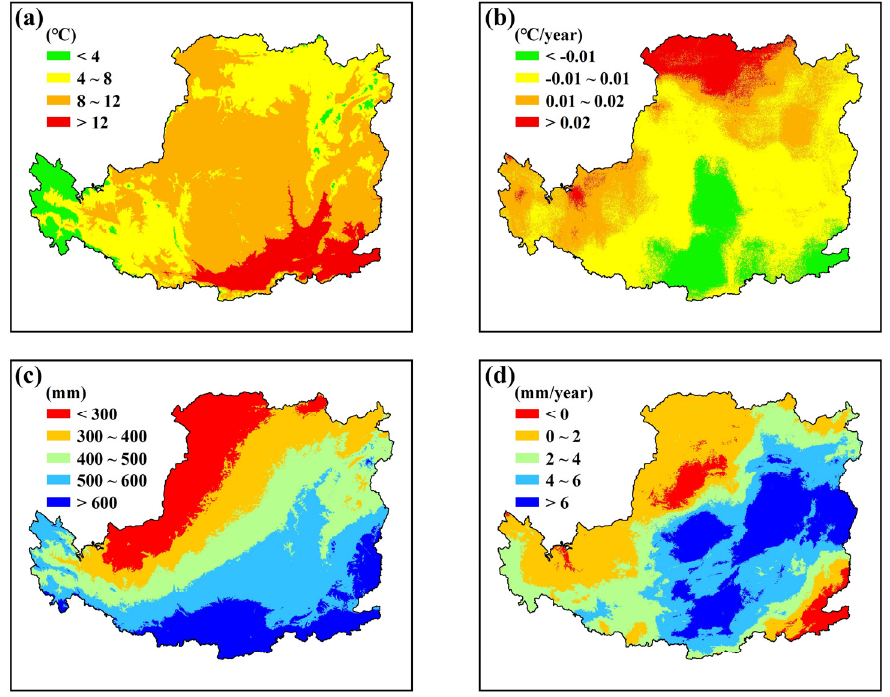
Figure 5. The spatial distributions of the annual mean temperature ( a ) and precipitation ( c ), and the slopes of the trends of temperature ( b ) and precipitation ( d ).